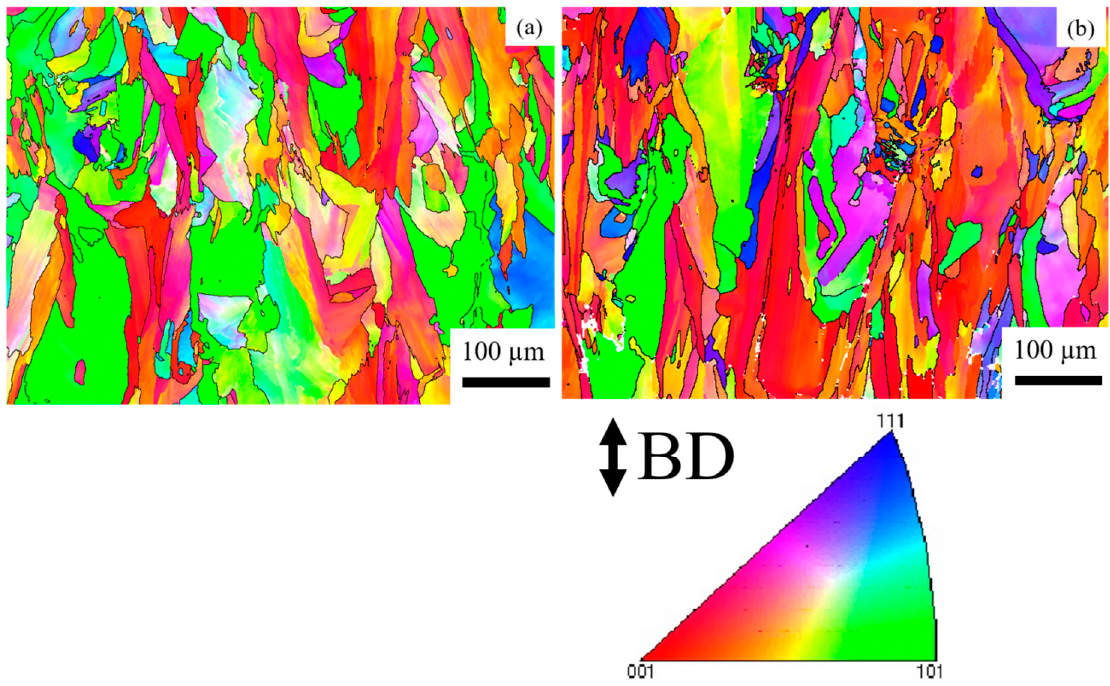
Figure 5. Inverse pole figure (IPF) maps of the as-built ( a ) HX and ( b ) HX-a specimens.